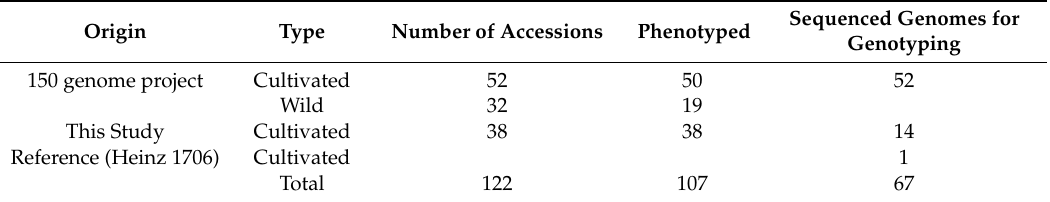
Table 1. Origin and analysis of the accessions that were used in this